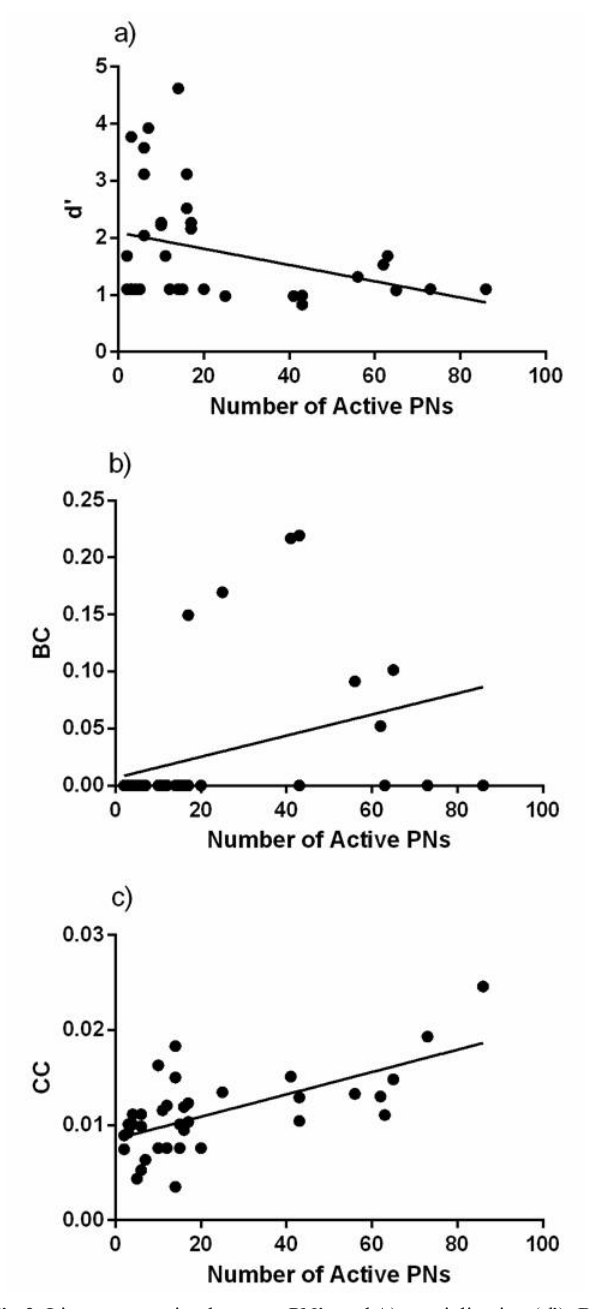
Fig 3 . Linear regression between PN’s and A) specialization ( d ’); B) betweenness and; C)